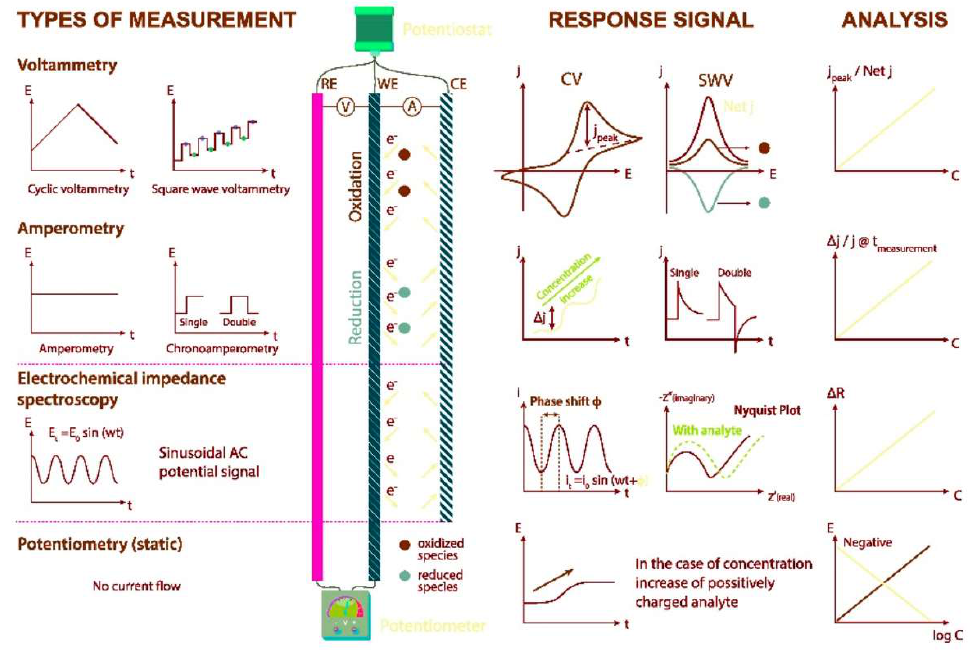
Figure 1. Classification of some electrochemical measurements (from ref. [10]).